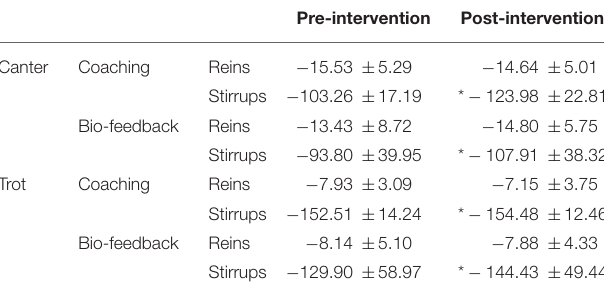
TABLE 1 | Rein and stirrup forces (in N) before and after the coaching and feedback interventions. Pre-intervention